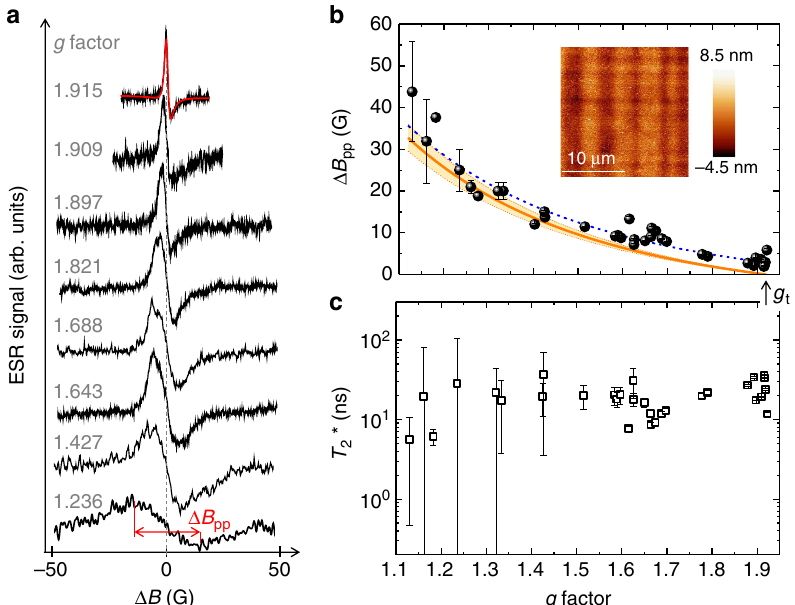
Figure 4 | CESR linewidth analysis. ( a ) CESR peaks for valleys A and B of the 20nm Ge QWs observed at the different g factors as a function of D B ¼ B (cid:3) B res , where B res is the the resonance field. The spectra are vertically shifted for clarity. The peak-to-peak linewidth D B pp of the ESR line at the smallest g factor is shown. The ESR line at g ¼ 1.915 is reported together with the Lorentzian-based composition of the three contributions (red line) to the ESR signal (see Supplementary Note 5). ( b ) Full dots are the measured D B pp for all the L-valleys as a function of g . Error bars were derived from least due to the interface roughness in squares fit of the lineshape of the resonance lines. The orange line is the calculated inhomogeneous broadening D B G pp , resulting from the roughness error. The dashed blue line corresponds 20nm Ge QWs. Shadowed area corresponds to the error bar of the calculated D B G pp to the orange curve, shifted by 2.9 G. Inset: AFM image of the surface of the sample having 20nm thick QWs. ( c ) T (cid:7) values obtained by the linewidth of the 2 broadening contribution due to the fluctuations of the QW width. Error bars of T (cid:7) were obtained by ESR lines, after removing the inhomogeneous D B G pp 2 taking into account the experimental error of the surface roughness as detailed in the Supplementary Note